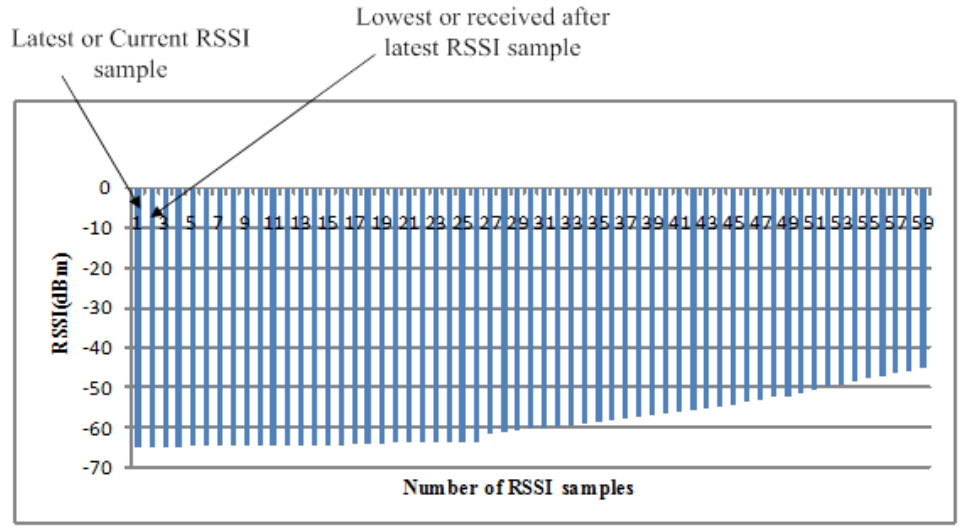
Figure 7. RSSI data samples during